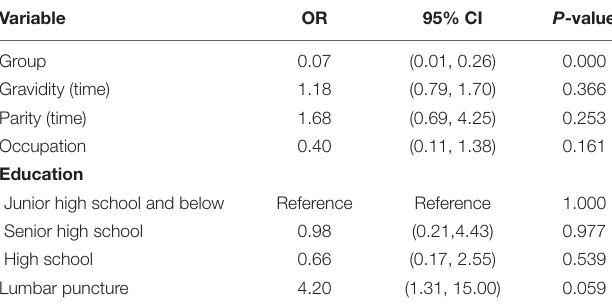
TABLE 4 | Univariate logistic regression. TABLE 5 | Multivariate logistic regression